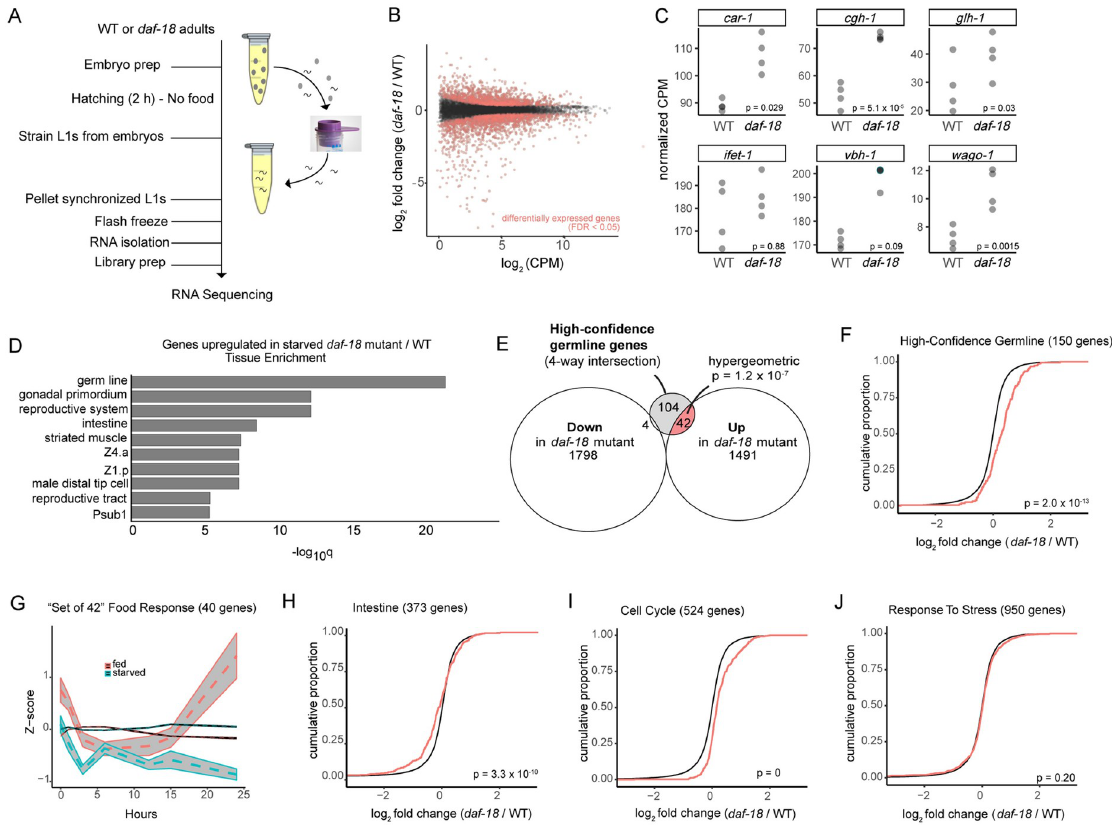
Fig 5. Transcript levels of a subset of germline genes are elevated in starved daf-18 mutants. (A) Schematic of RNA-sequencing experiment. Starved L1s were isolated within 2 h of hatching, pelleted, frozen, and mRNA sequencing was performed. (B) Plot of log 2 fold change (in GC1459 daf-18(ok480) / GC1171 wild type (WT) versus expression level of 12,592 transcripts detected. Red color dots represent transcripts expressed differentially (below cutoff of FDR 0.05). (C) Transcript levels of genes previously shown to be induced zygotically by feeding [55] or by daf-18 mutation (this study). Uncorrected p-values are displayed since comparisons were hypothesis-driven. (D) Tissue enrichment analysis of genes upregulated in daf-18 mutant/WT using WormBase web tool. Germ line is the most significantly represented tissue in daf-18 mutant-upregulated genes. (E) Venn diagram of transcripts significantly upregulated or downregulated in daf-18 mutants (FDR < 0.05) and overlap with the set of “high-confidence germline genes,” or transcripts found in all of 4 published germline sets [41,45,58,65]. Hypergeometric p-value is displayed for daf-18 up-regulated genes overlap with high-confidence germline genes (while p = 1 for overlap of daf-18 downregulated genes with high-confidence germline genes). (F-I) Cumulative distribution function (CDF) plots of transcript sets of interest (red line) versus the background set of all 12,592 transcripts detected (black line). Shift to the right indicates overall increased expression of gene set. p-values determined by Kolmogorov-Smirnov (KS) test are shown. Numbers of transcripts from published gene sets detected in our experiment are shown in graph titles (parentheses). (G) Fed versus starved L1 expression (data from Baugh et al., 2009) of our set of DAF-18-repressed high-confidence germline genes. Mean Z-score (and 95% confidence intervals) of these 40 genes (of 42 we identified in E also detected in this study) over time are plotted in grey, while the thin, black lines represent the Z-scores for the entire background set (11,107 genes from Baugh et al., 2009 that were also detected in this study). (H) Intestine gene set [45], data accessed by GExplore1.4 web tool) shows significant differential expression in daf-18 , but many genes are downregulated. I. and J. show significant upregulation (Cell Cycle) and no significant change (Response to Stress) of gene sets of interest.